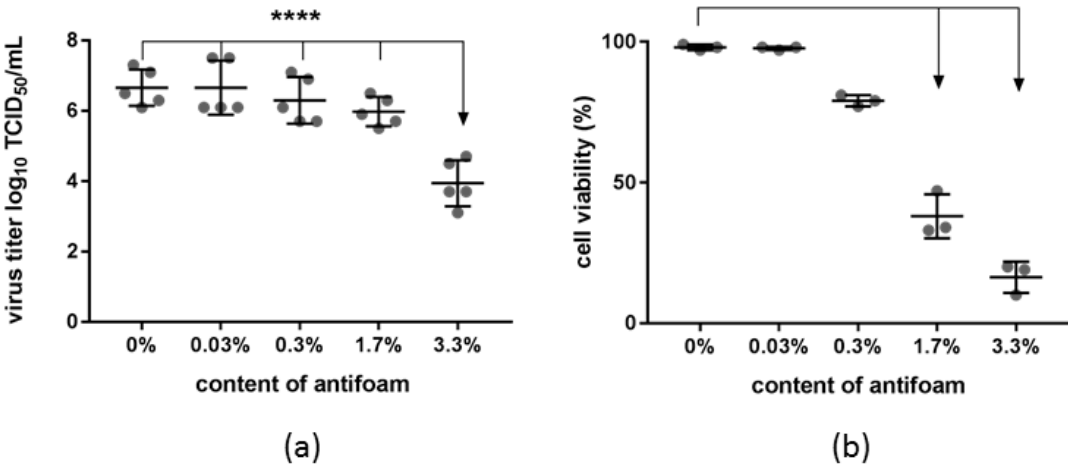
Figure 1. Impact of antifoam in the cell culture media on viral yield in infected cultures and cell viability in the absence of infection. Antifoam was added to the media at a final concentration of 0.03, 0.3, 1.7 or 3.3% ( v / v ). A culture with no additives served as a control. ( a ) Cells at a density of 1 × 10 6 cells / mL were infected with Foot-and-mouth disease virus (FMDV) O SAU / 18 / 2018 at a multiplicity of infection (MOI) of 0.01 and the viral harvest at 20 hpi is shown as log 10 TCID 50 / mL. ( b ) Antifoam was added to non-infected cells (1 × 10 6 cells / mL) and cell viability was measured after 20 h of culturing. Experiments were performed three times independently. Significance code: “****” p ≤ 0.0001.